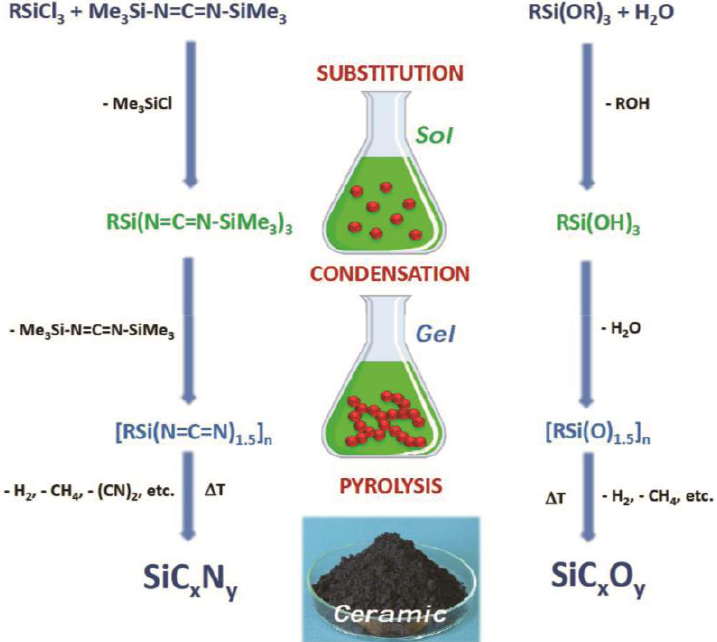
Figure 3. Comparison between the non-oxide sol–gel process for the synthesis of polysilylcarbodiimides and the oxide sol–gel process for the synthesis of